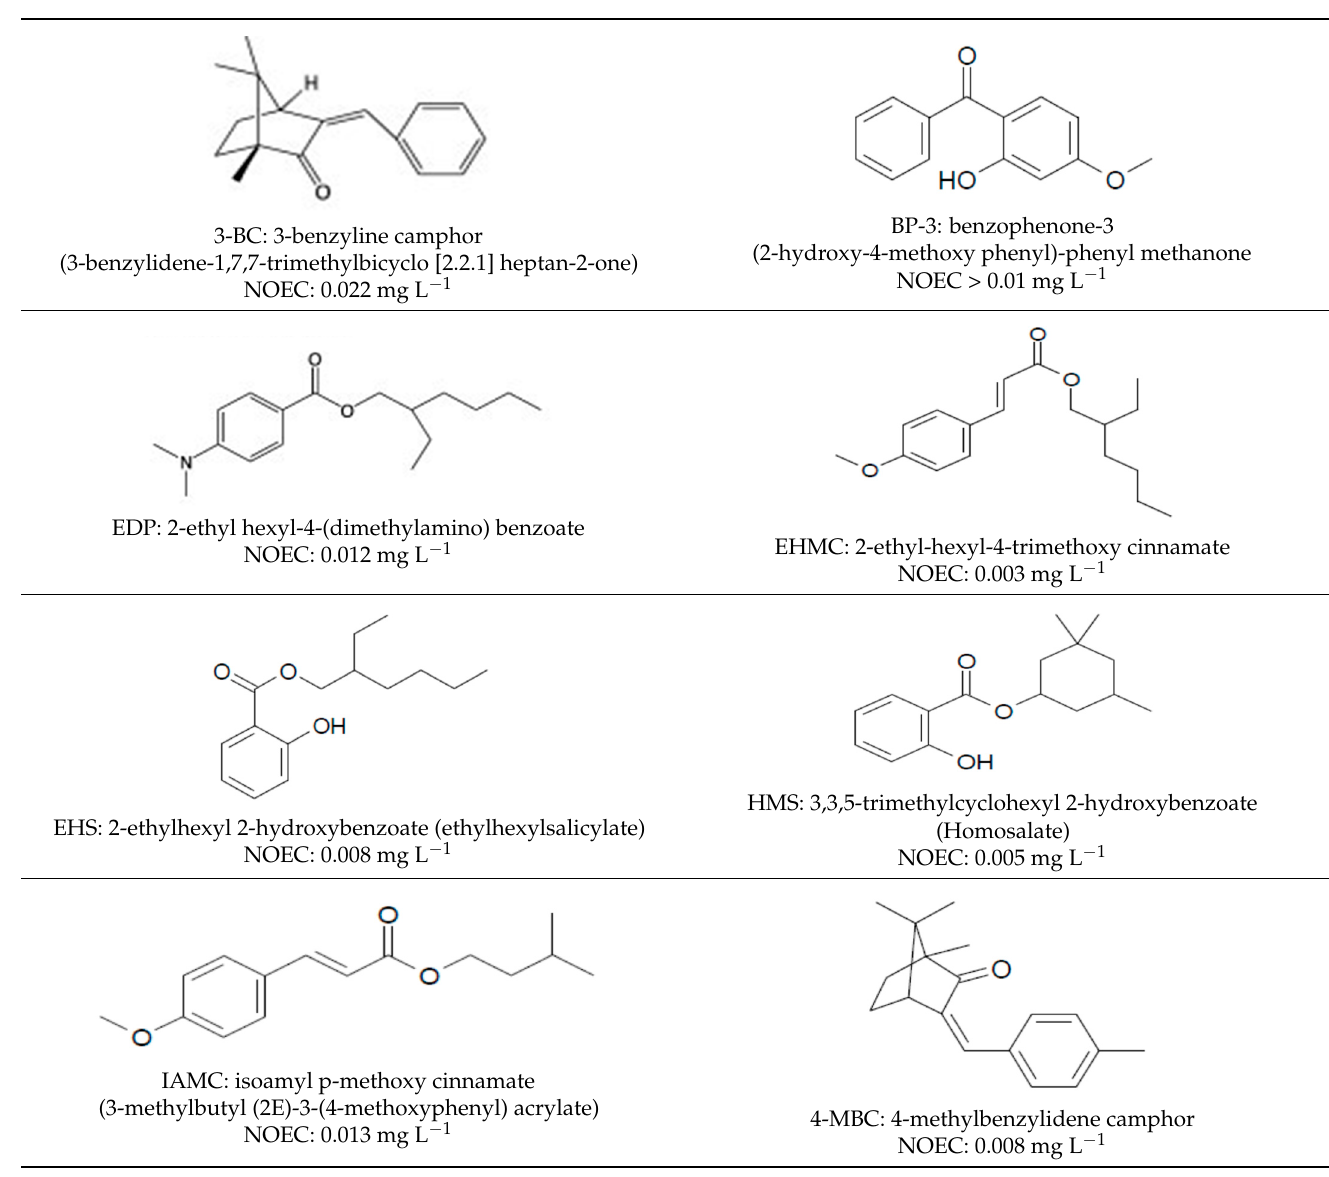
Table 1. Chemical Structures, IUPAC names and NOEC concentration of selected UVFs.